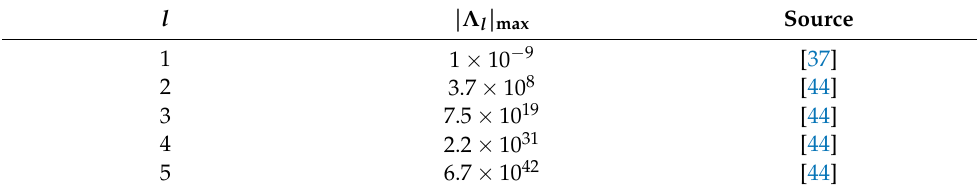
Table 1. The strongest current constraints on the potentials of power